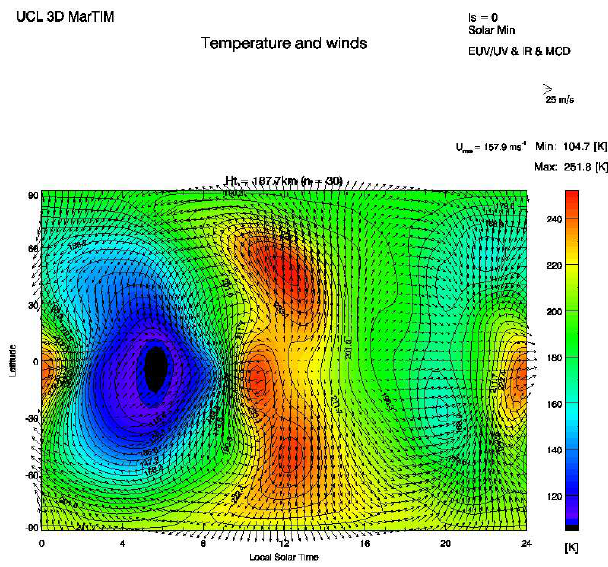
Fig. 9. The temperature and horizontal winds at the lower boundary of the model – pressure level 1.